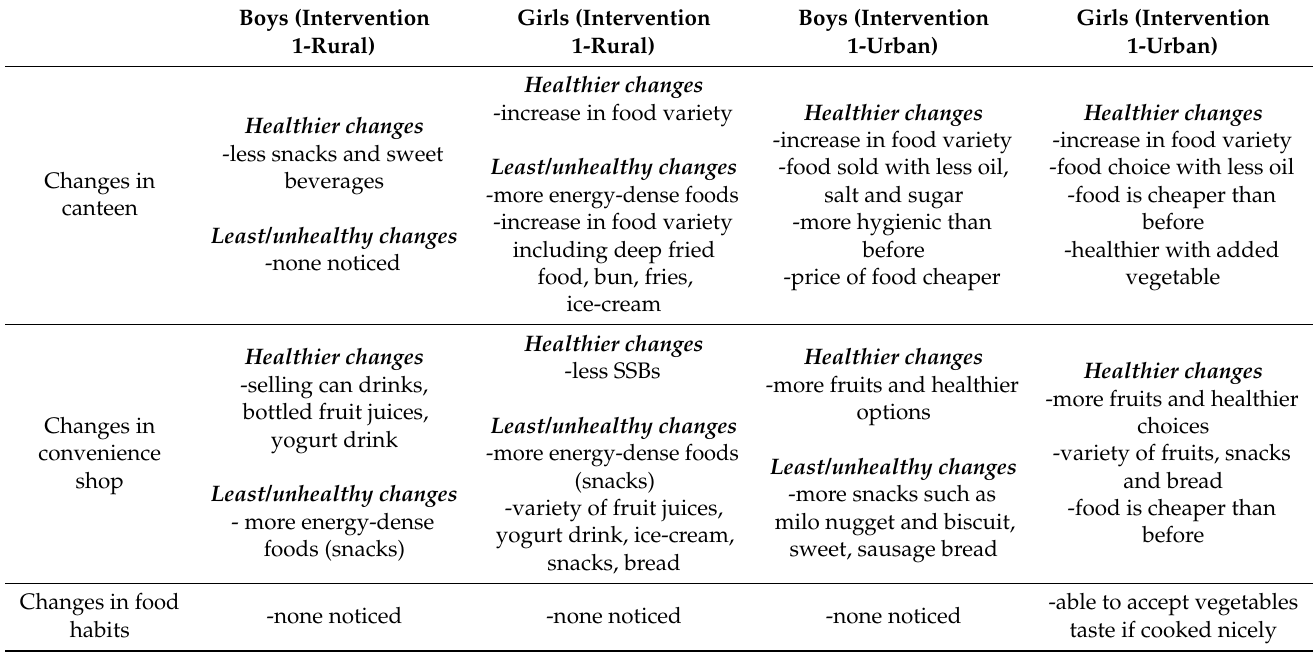
Table 3. Changes, Challenges and Barriers to Healthy Eating at School after the End of The Intervention (Intervention Arms 1- training